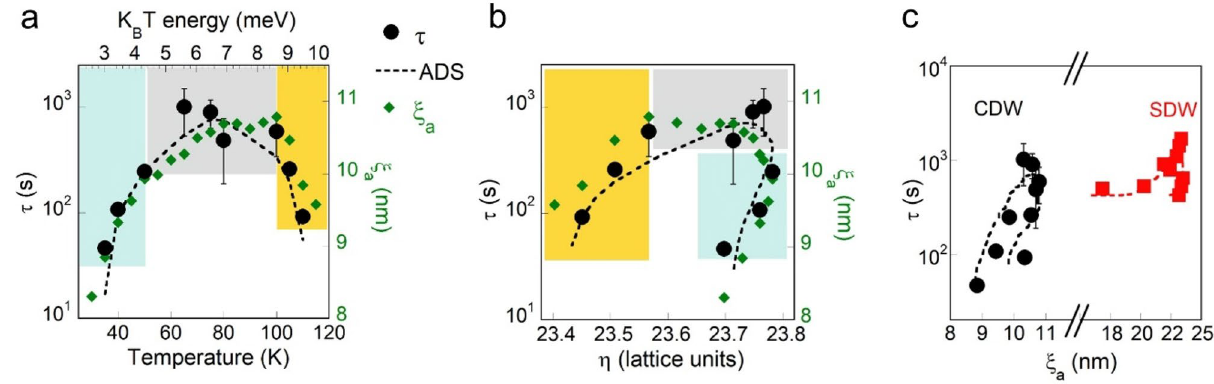
Figure 2. Correlations between CDW and SDW domain size and dynamics in La 1.71 Sr 0.29 NiO 4 . ( a ) Characteristic decay times, τ, of CDW (black full circles) along the fit (dashed line) extracted in the modified Activated Dynamical Scaling (ADS) model described by Eq. (3), as a function of temperature in logarithmic scale. The behavior of τ is compared with the (full diamonds) in plane coherence length, ξ a . We observe how lower delays correspond to lower coherence lengths that is to smaller domains in both low temperature (light blue) and high temperature (yellow) regions. ( b ) Time delay, τ, (black full circles), and ξ a (full diamonds) of CDW, as a function of the incommensurability, η = 14/H, where H is the CDW wavevector along the a* direction (see “Methods”). Here lower values of delays and coherence lengths occur in the low temperature (light blue) and high temperature (yellow) regions. The fit of τ as a function of T and ξ a extracted from the ADS theory is represented by the black dashed line. ( c ) The correspondence between time delays, τ, and domain size, ξ a , for CDW has been compared with time delays and domain size in SDW measured in the same sample, as reported in ref. 20 . The dashed lines represent always the fit of τ as a function of T and ξ a extracted from the ADS